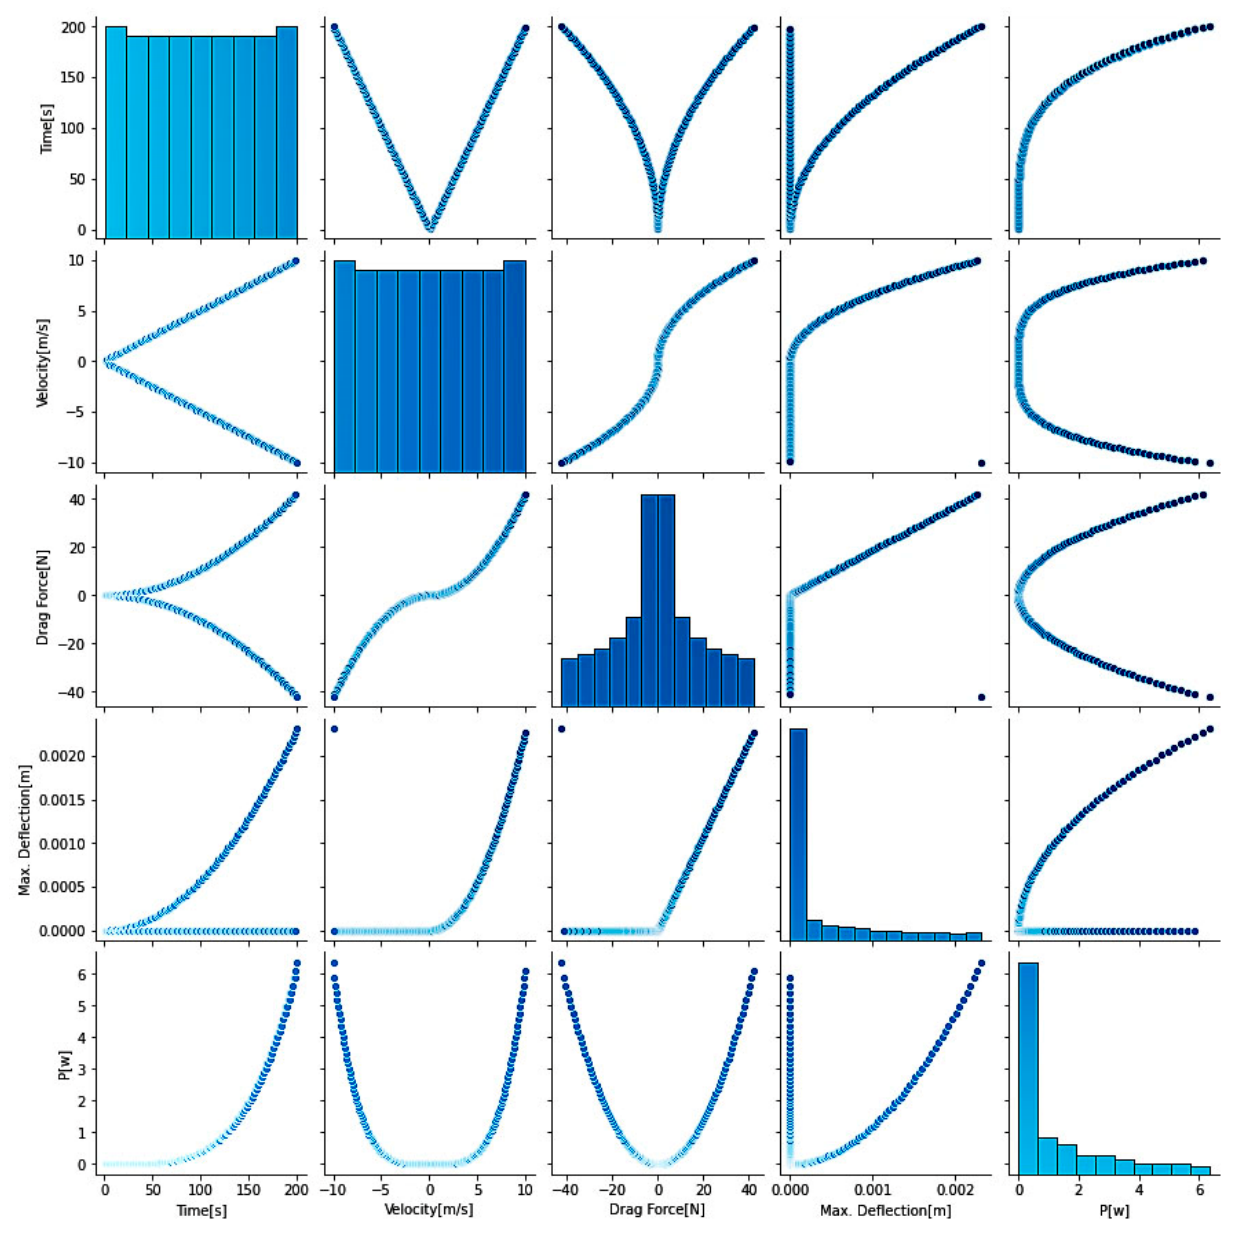
Figure 7. The overall figures of different parameter correlations.